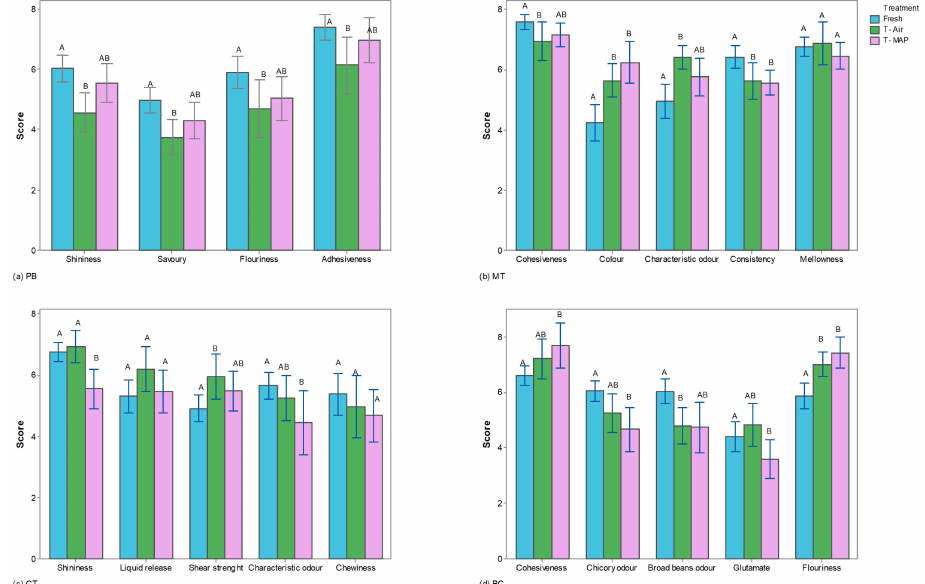
Figure 3. Results of QDA reporting the intensity of the sensory attributes for each meal (PB: Pasta and broccoli rabe; MT: Meatballs with tomato sauce; CT: Cod with tomato sauce; BC: Mashed broad beans with chicory) and for each treatment (Light blue bars: Fresh, day 0; green bars: T-Air, packed in air; pink bars: T-MAP, packed in modified atmosphere). For each attribute, treatments (bars) with di ff erent letters are significantly di ff erent (Tukey’s LSD, p <